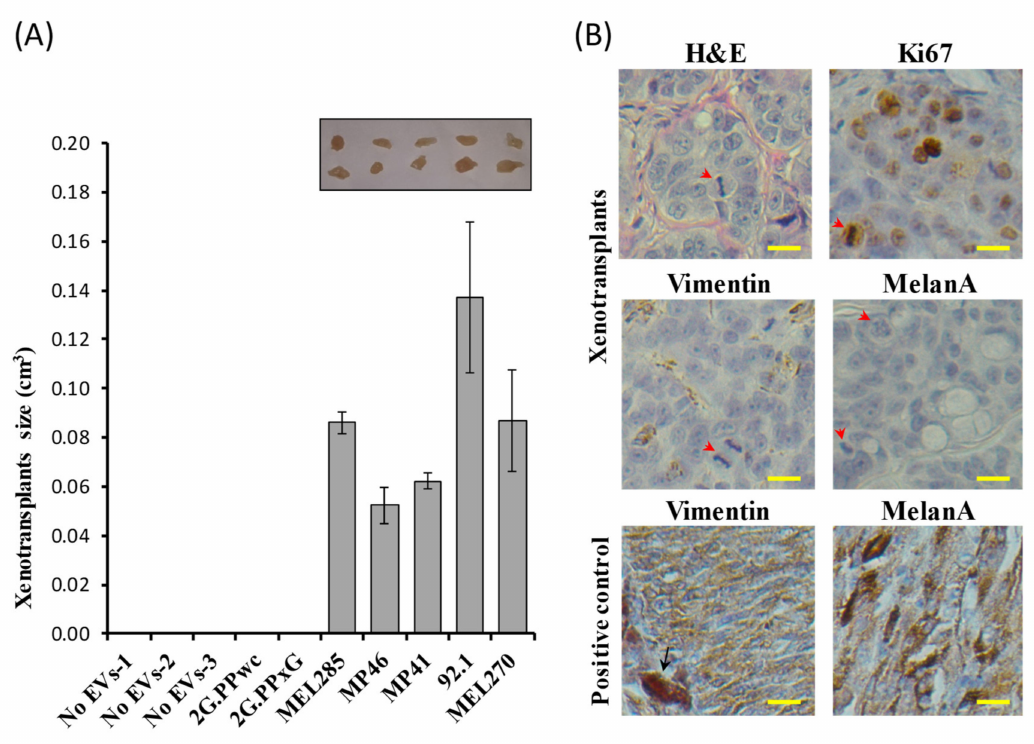
Figure 4. In vivo tumorigenicity assay of Fibro-BKO cells treated with UM-EVs ( A )Exposed cells were injected subcutaneously into NOD / SCID mice that were monitored for 4 weeks for tumors growth. At euthanasia, developing tumors were excised and their sizes were measured. ( B ) Formalin-fixed para ffi n-embedded tumors were processed for H&E staining, and immunolabeled with anti-Ki67, anti-Vimentin and anti-MelanA antibodies. Scale bar: 10 µ m. Red arrowheads pointed to mitotic figures, and black arrow pointed to a melanophage. Positive controls are from choroidal melanoma